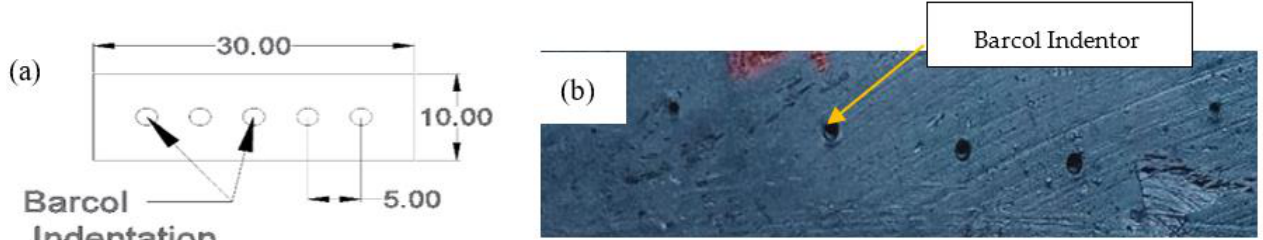
Figure 2. Hardness specimen of composite: ( a ) geometry of hardness specimen; ( b ) indentations made using Barcol hardness tester .